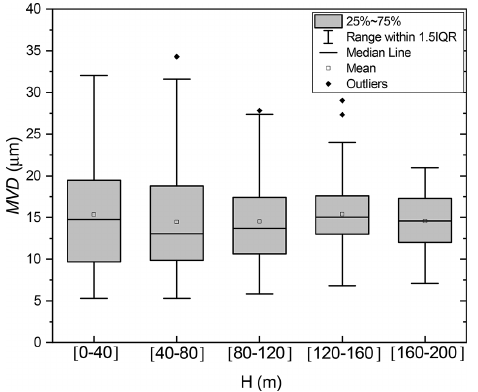
Figure 11. Statistical description of hourly averages of median vol- ume diameter (MVD) measured by the cloud and aerosol spectrom- eter (CAS) and the forward-scattering spectrometer probe (FSSP) where PES was within one region > 80% for five different levels of the position of the probes inside the cloud ( H ) (relative distance of the cloud ground-based spectrometer). Cloud base was measured at the Kenttärova